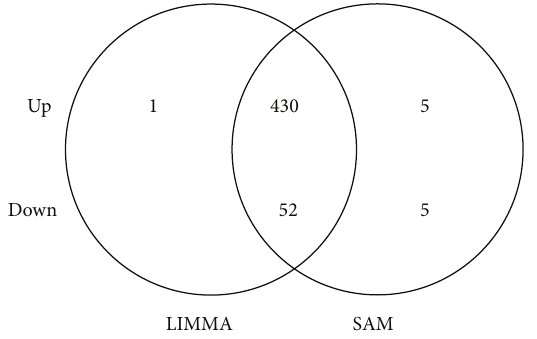
Figure 1: Comparison of two distinct approaches for screening of differentially expressed genes in RTT PBMC. Venn diagram repre- sentingnumbersofcommonandexclusivelyup-anddownregulated genes for LIMMA (left) and SAM (right) analyses (FC ± 1; adj. 𝑃 value ≤ 0.05). The 11 genes indicated by only one method were excluded by further